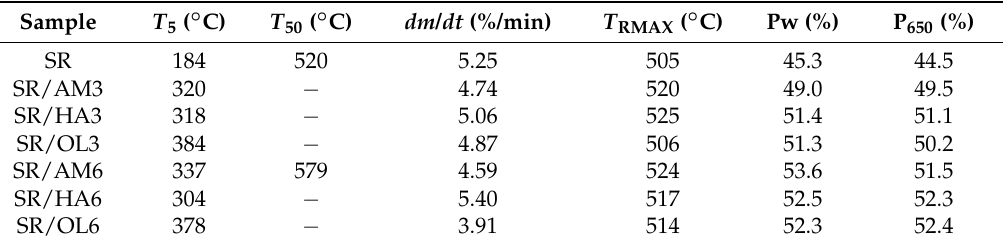
Table 4. Activation energy values of SR/POSS composites.